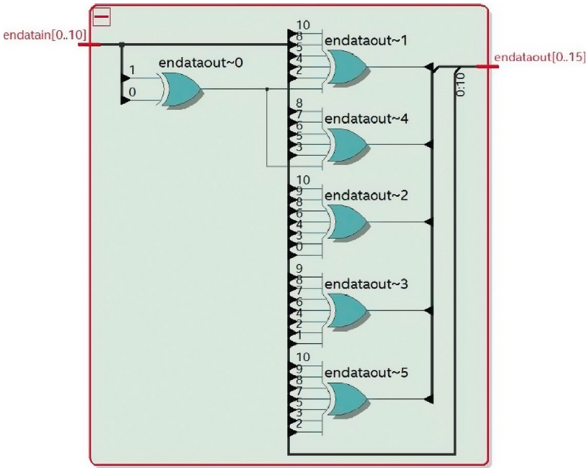
Figure 11: RTL overview of the encoder for Hamming [16, 11, 4]